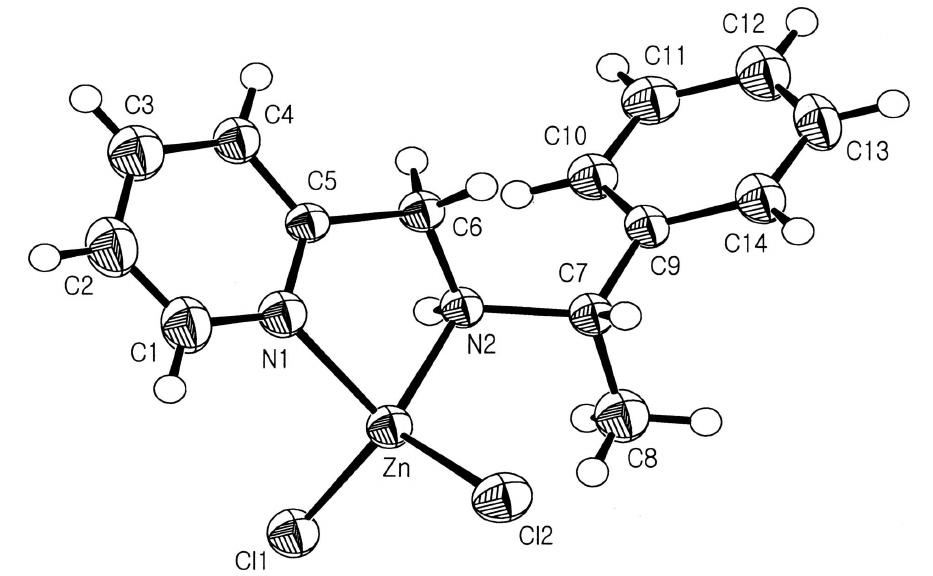
Figure 1 The molecular structure. Displacement ellipsoids are drawn at the 40% probability level. Dichlorido[( S )-(1-phenylethyl)(2-pyridylmethyl)amine- κ 2 N , N ′